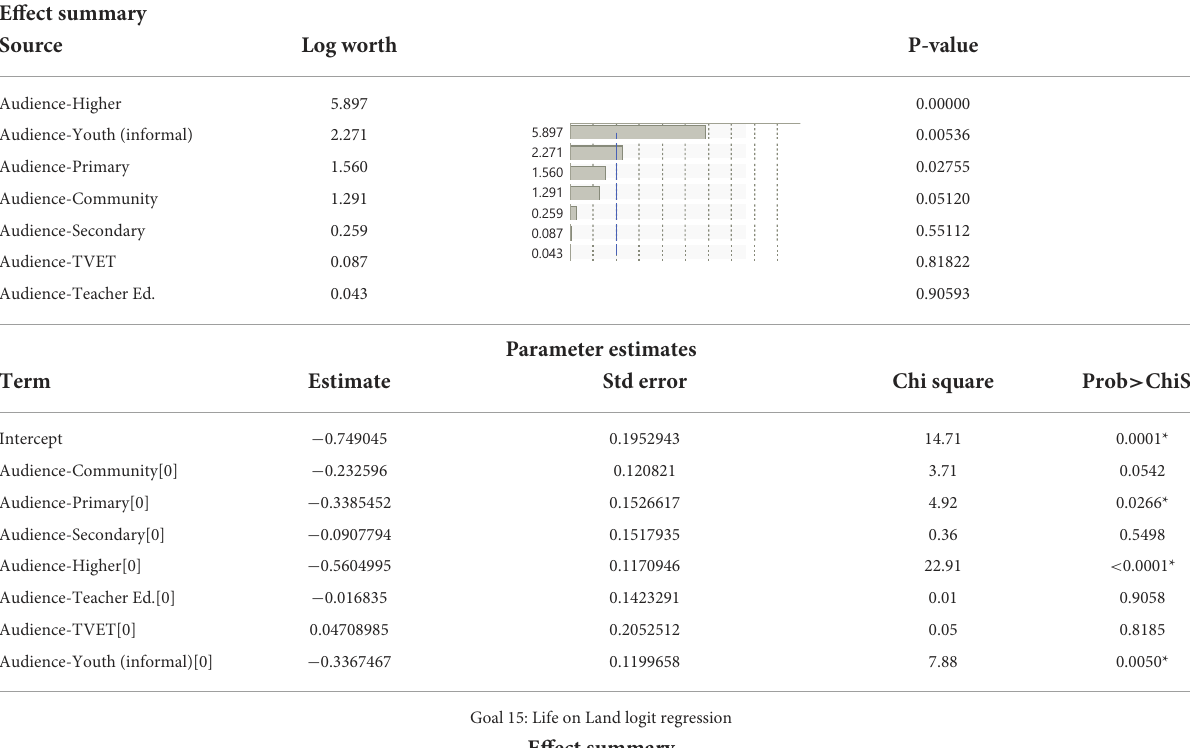
TABLE 4 Effect and parameter estimates on the likelihood of RCE projects to focus on specific audiences of learners for SDG 13 (Climate Action) and SDG 15 (Life on Land). Goal 13: Climate Action logit